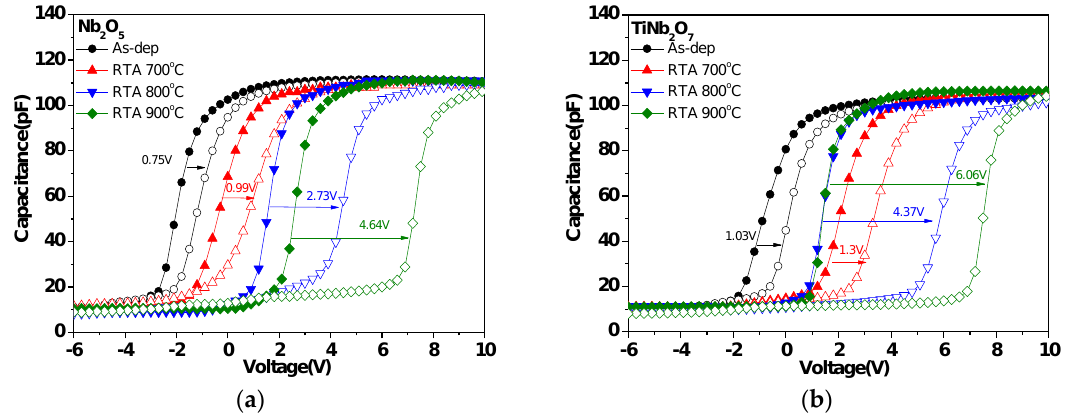
Figure 2. ( a ) High frequency C-V curves of Al/SiO 2 /Nb 2 O 5 /SiO 2 /Si structure after annealing in different temperatures; ( b ) high frequency C-V curves of Al/SiO 2 /TiNb 2 O 7 /SiO 2 /Si structure after annealing in different temperatures.